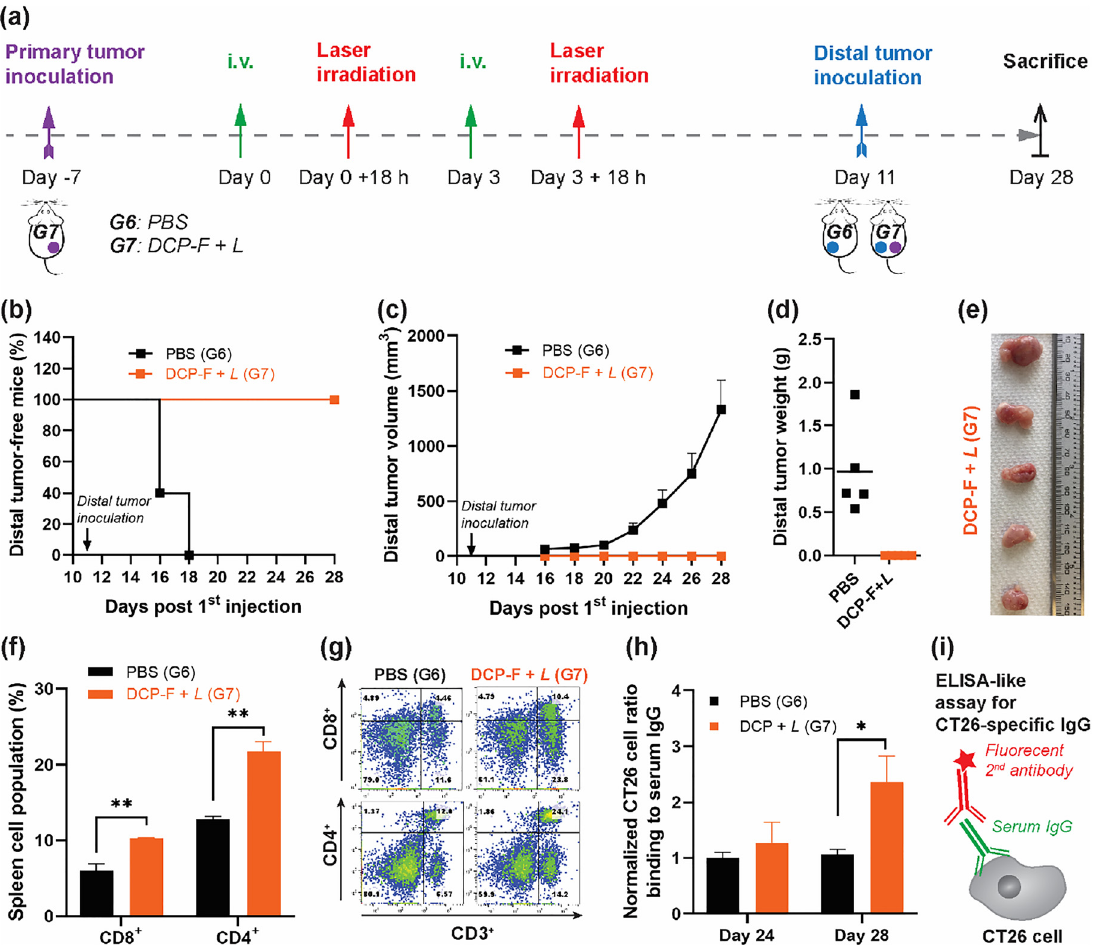
Figure 6: Tumor rechallenge after PBS and DCP-F + L treatments. (a) Tumor inoculation and treatment schedule; (b) ratio of the distal tumor occurrence and (c) distal tumor growth pro fi le after rechallenge; (d) distal tumor weight and (e) images at day 28; (f) spleen lymphocyte population and (g) representative cytometric images; (h) ratio of CT26 cells speci fi c binding to serum IgG collected at day 24 and 28 of 1st post-injection (normalized to that before tumor inoculation); and (i) schematic of ELISA-like assay for CT26-speci fi c